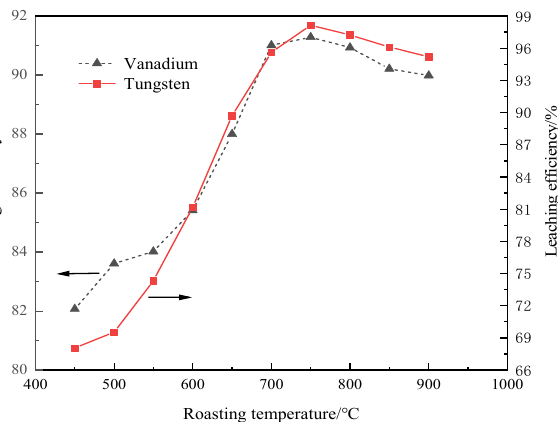
Figure 4. The effect of the roasting temperature on the leaching efficiencies of V and